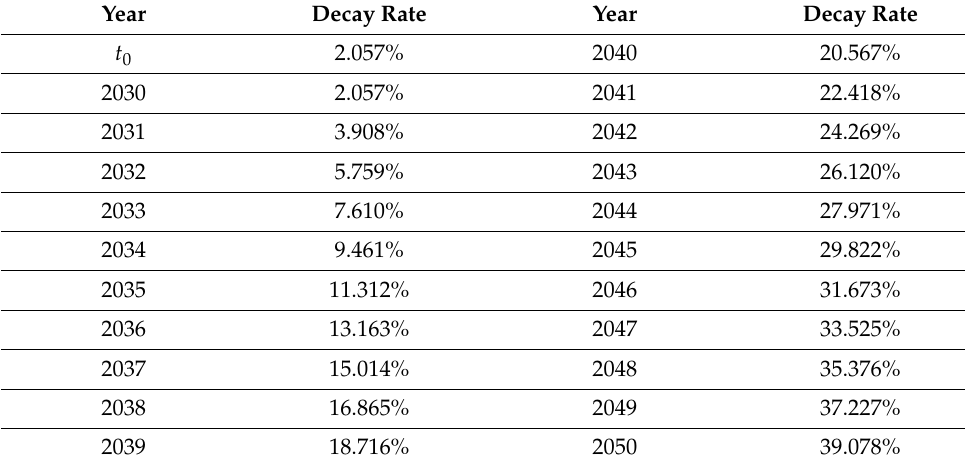
Table 1. Annual decay rate from 2030 to 2050 in our